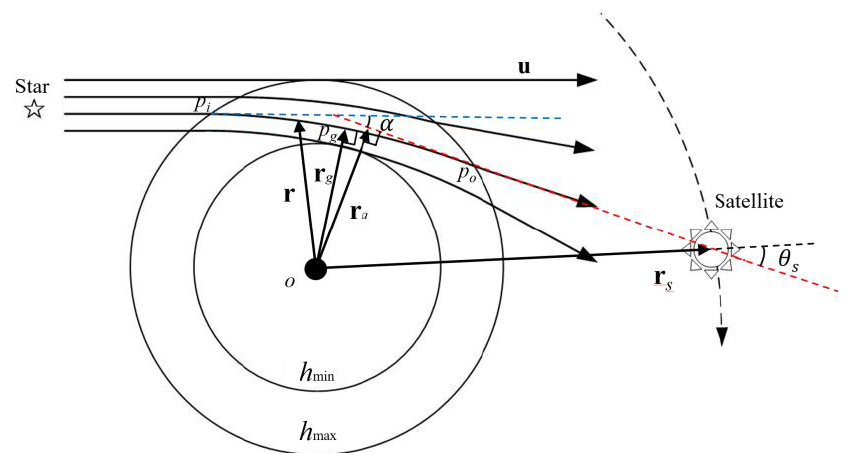
Figure 1. Schematic diagram of the star occultation.